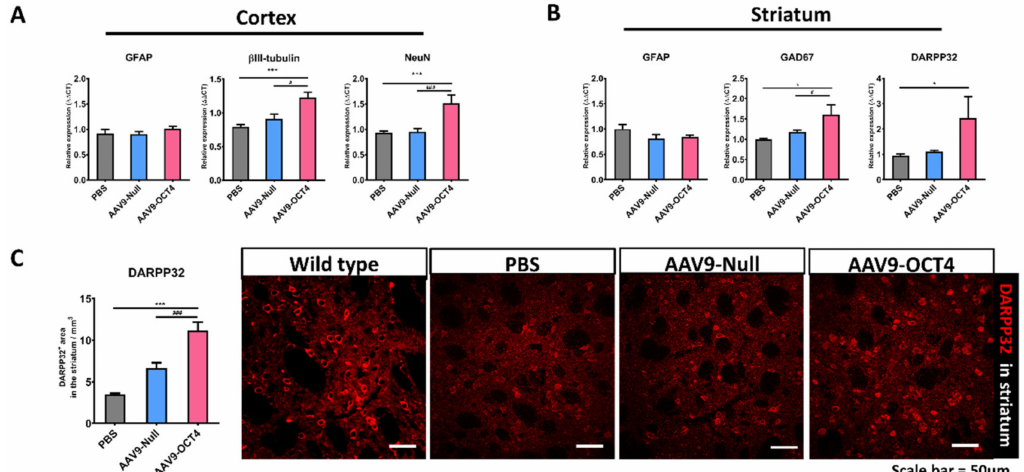
Figure 6. OCT4-induced OPCs induce neuroprotection. ( A ) To confirm neuropretection in the cortex ( B ) and striatum among three groups at 13 weeks of age by qRT-PCR. AAV9-OCT4 group displayed significantly increased expression of β III tubulin (F = 12.271, *** p < 0.001; # p = 0.004), NeuN (F = 13.477, *** p < 0.001; ### p < 0.001), a neuronal marker in the cortex and GAD67 (F = 8.057, * p = 0.001; # p = 0.033) and DARPP32(F = 3.794, * p = 0.047), a GABAergic neuronal marker in the striatum. However, the AAV9-OCT4 group did not change the expression of GFAP, an astrocytic marker in both regions ( C ) In the striatum, AAV9-OCT4 group significantly increased the area of DARPP32 + GABAergic neurons compared to controls (F = 18.697, *** p < 0.001; ### p < 0.001). *,# p < 0.05, ***,### p < 0.001, Data in all panels represent mean ± SEM. *PBS vs. AAV9-OCT4, #AAV9-Null vs. AAV9-OCT4. PBS group (N = 4); AAV9-Null (N = 4); AAV9-OCT4 (N =